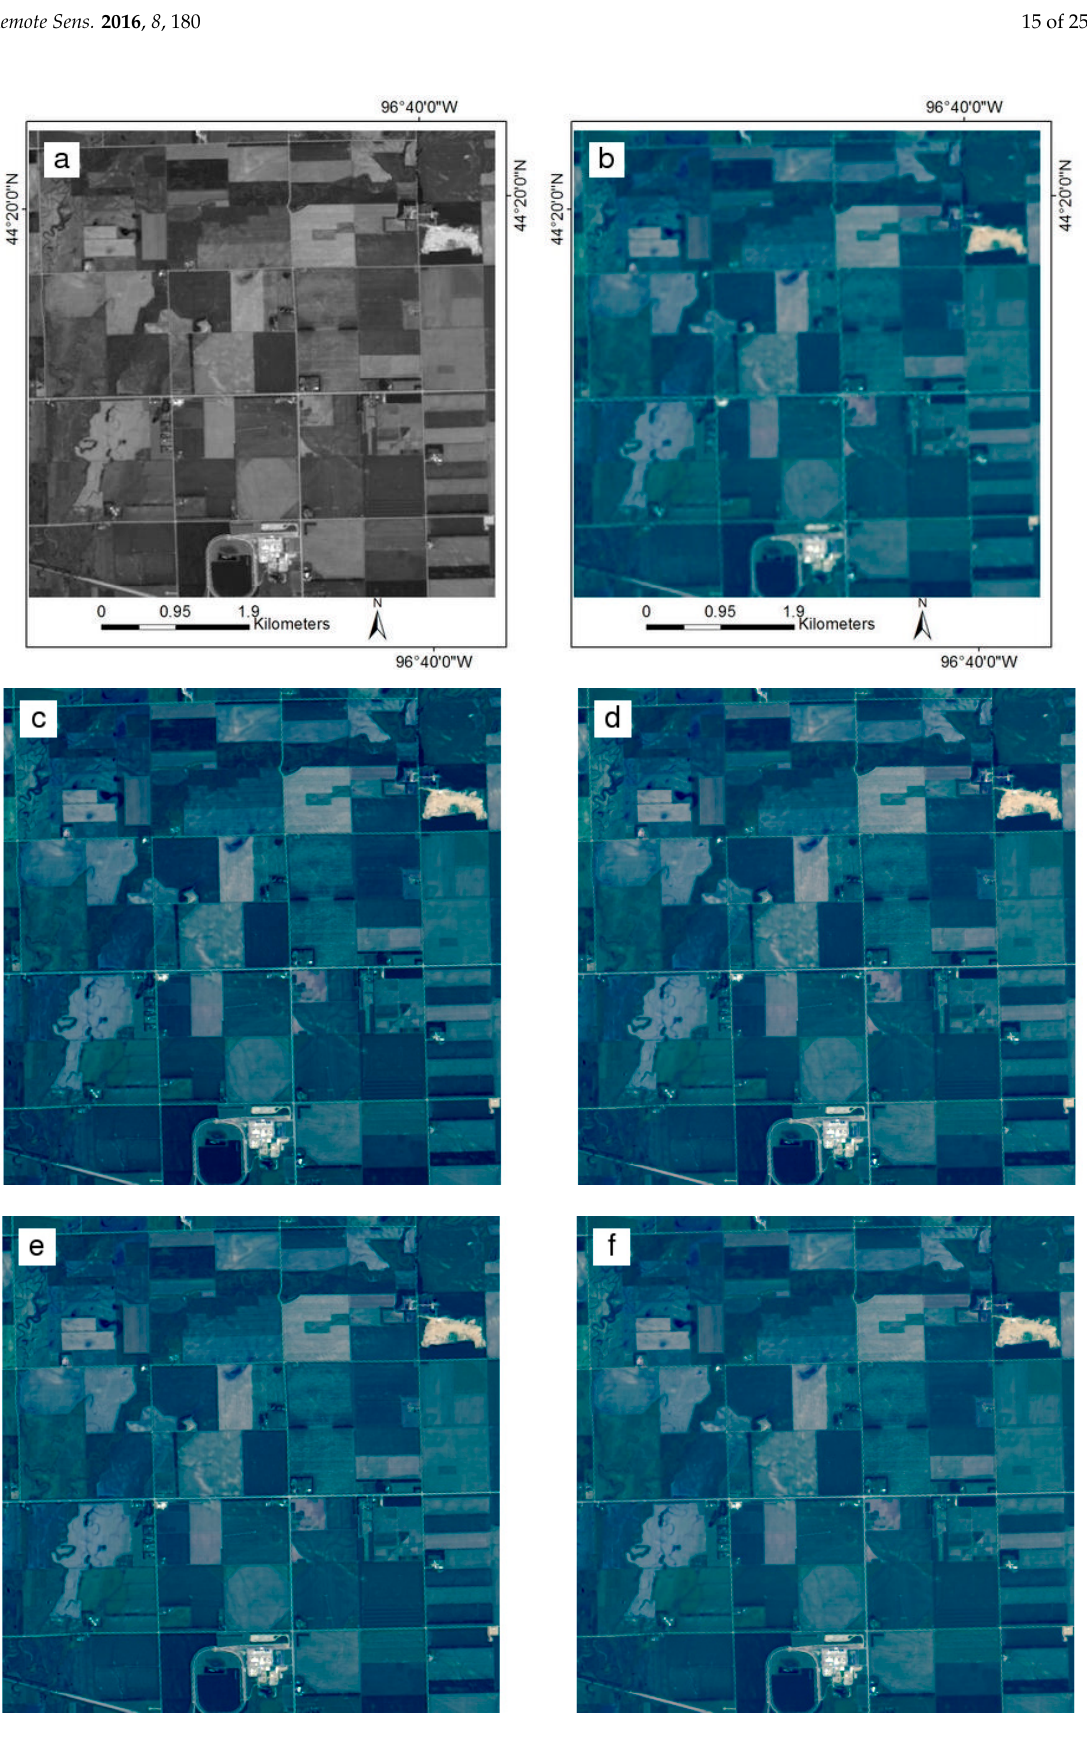
Figure 6. Cont. Figure 6.